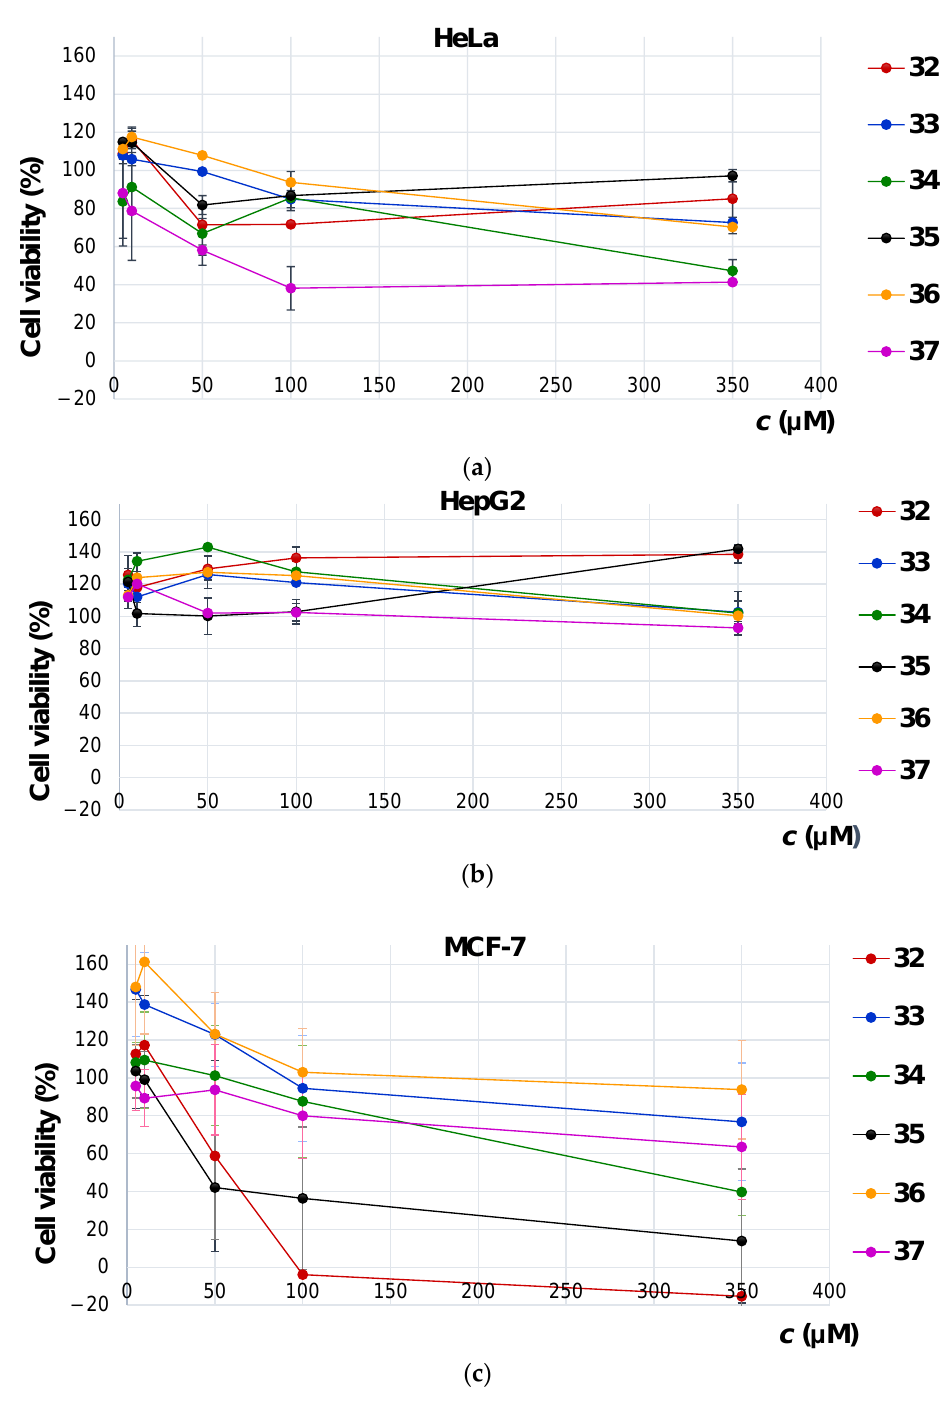
Figure 11. Dose response curves for tested compounds 32 – 37 in Hela ( a ), Hep G2 ( b ), and MCF-7 ( c ) cells. Cells were treated with 5 different concentrations of compounds (5, 10, 50, 100, and 350 uM) and their viability was assessed by MTT test after 72h of incubation. Average ± s.d. from 3 biological replicates is shown.